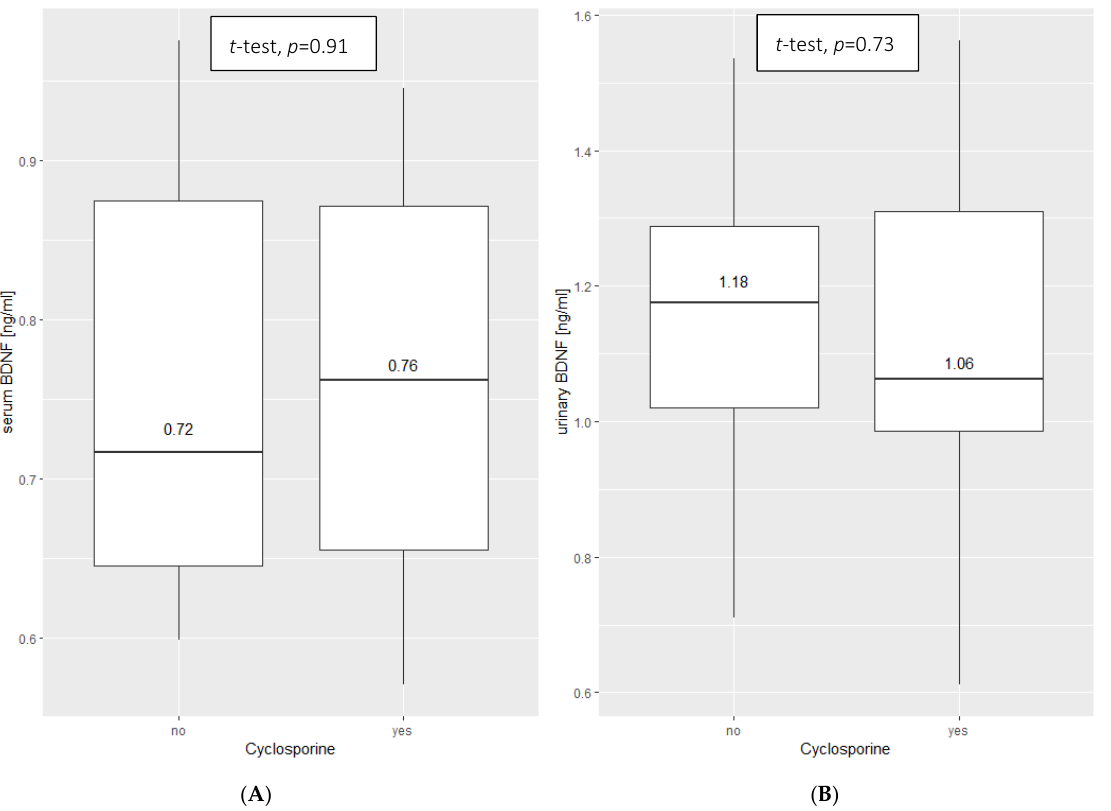
Figure 4. The comparison of BDNF concentration in the study group in serum ( A ) and urine ( B ) between the patients treated with cyclosporine (yes) and treated with other medicine (no), (Student’s t -test for independent samples).